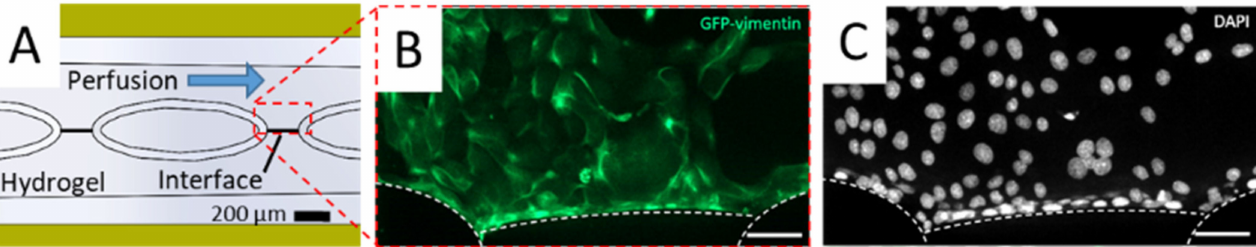
Figure 4. Fluorescence microscopy characterization of cellular barriers in MFC. ( A ) Schematic figure of location of cellular barrier on the interface between gel phase and perfusion channel. ( B ), ( C ) Cellular barrier comprised of MDCK_VB6-CB cells. Cells are located on the interface between the perfusion channel and hydrogel as well as on the surface of micro pillars and proliferate to eventually cover the complete surface of the perfusion channel. Cells expressing green fluorescent Vimentin chromobody (VB6-CB B) were fixed with PFA and DAPI staining was performed ( C ). Cells were seeded at a density of 10 5 cells per channel at passage 3. Staining was performed at day five after seeding. Single slice confocal microscope image at bottom of the channel. Scale bar 50 µ